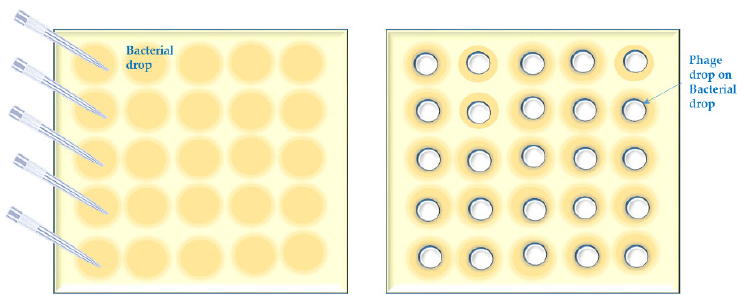
Figure A3. Diagram depicting the “spot on spot” method.